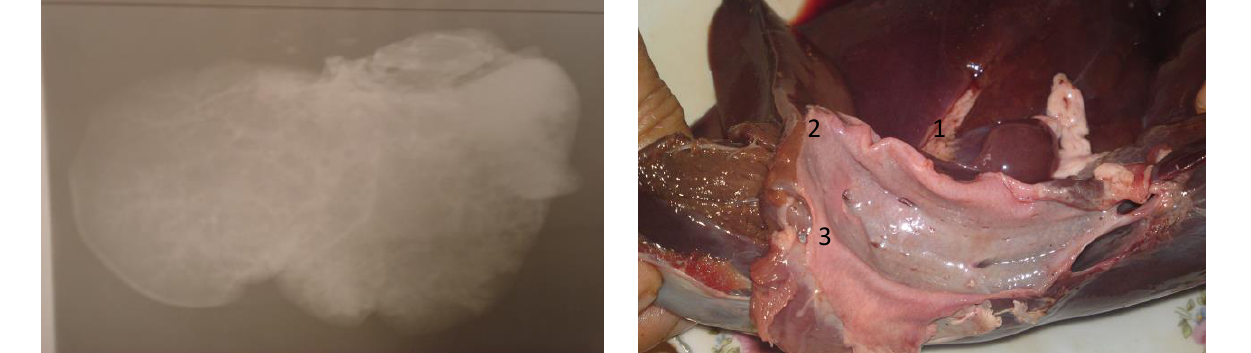
Figure, 10:Hepatic vein divided into 1-right 2- intermediate and 3-left branches by X ray